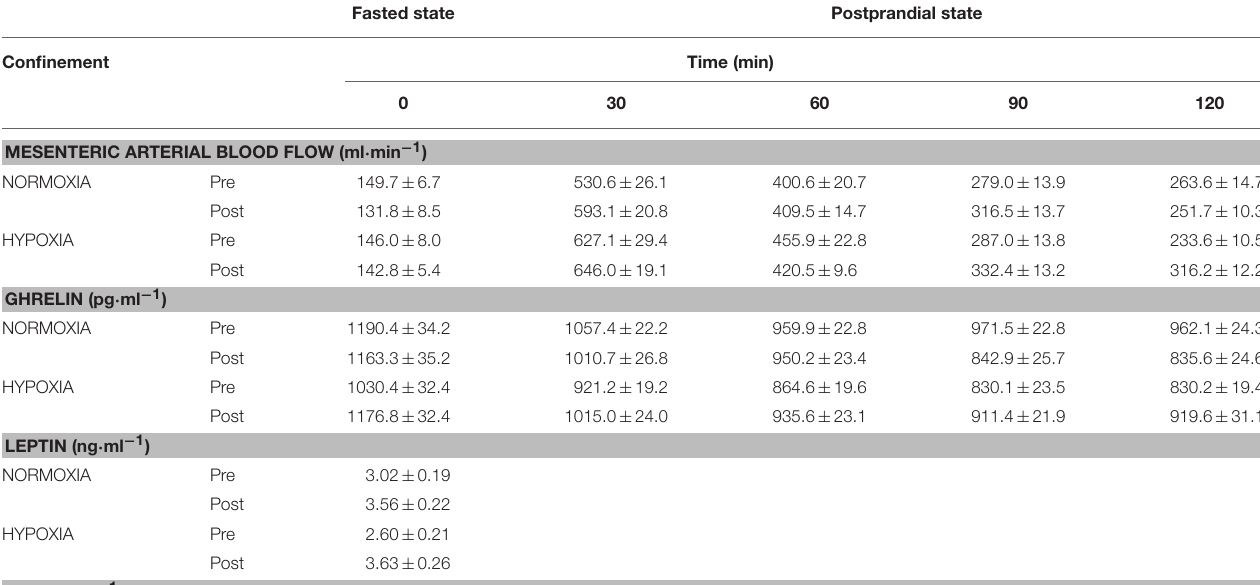
TABLE 2 | Fasted and mean postraprandial mesenteric arterial blood flow, ghrelin, peptide YY 3 − 36 (PYY), adrenaline and noradrenaline and subjective composite satiety score (CSS) evaluation before (PRE) and after (POST) the 10-day NORMOXIA and HYPOXIA confinements. Fasted